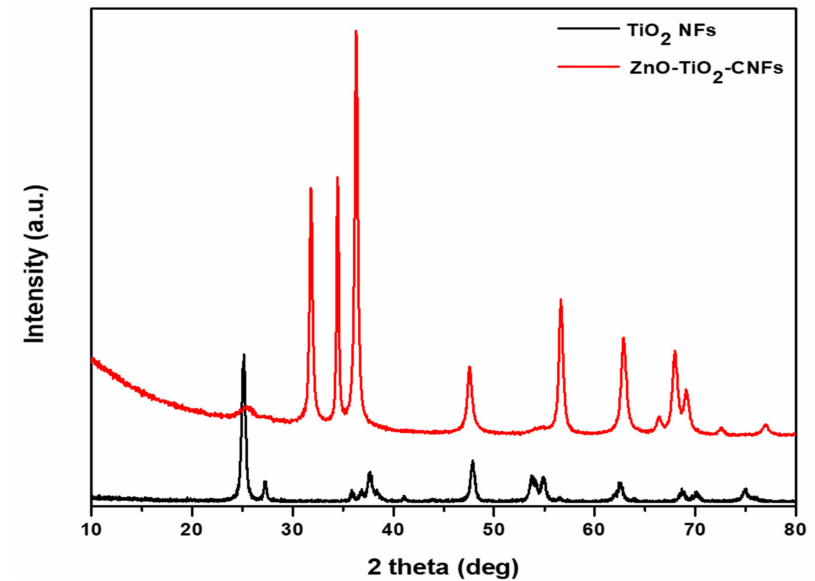
Figure 4. XRD spectra of TiO 2 NFs and ZnO-TiO 2 -CNFs